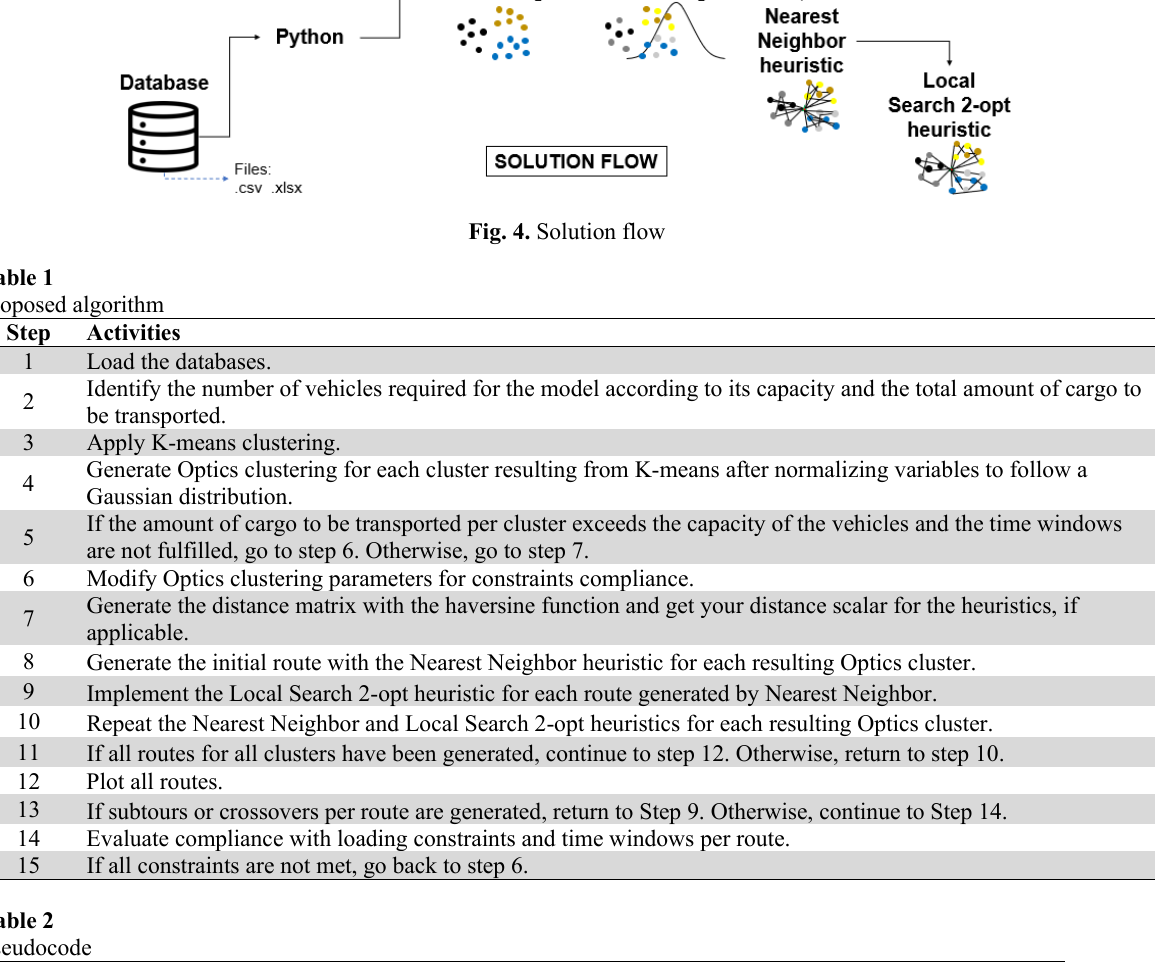
Algorithm for VRPTW (K-means, Optics, Nearest Neighbor and Local Search